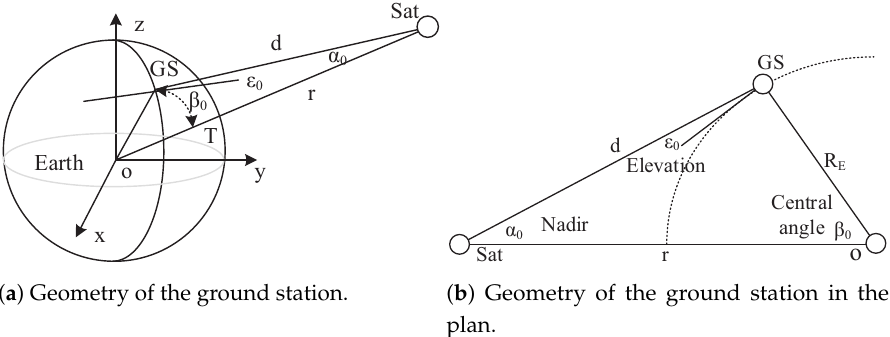
Figure 6. Geometry of the ground